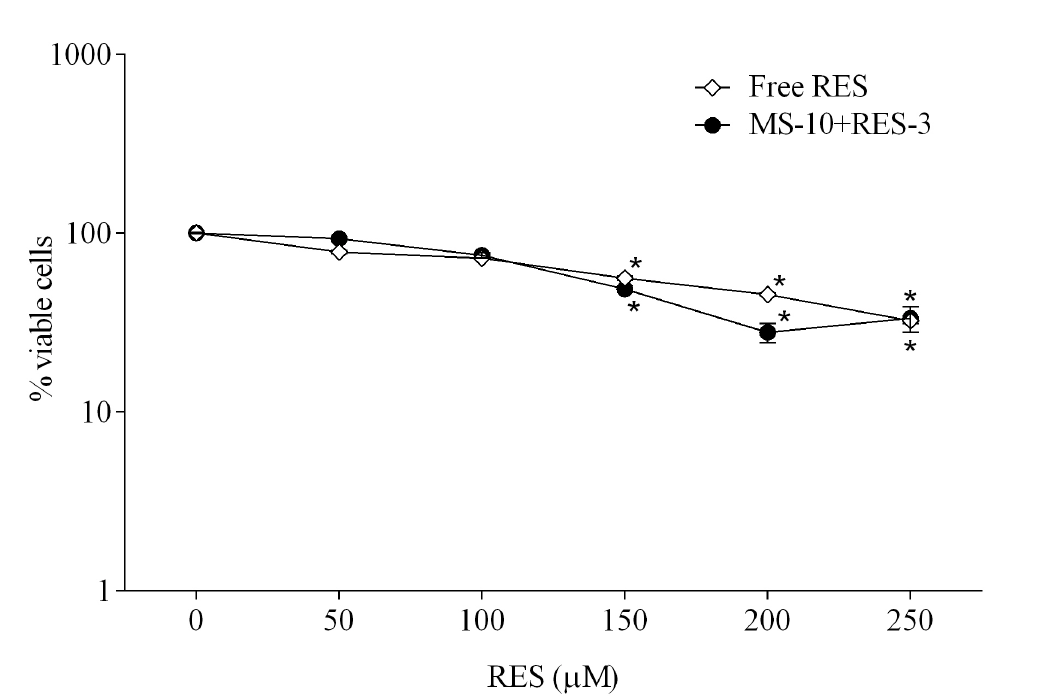
FIGURE 4 - Percentage of viable T24 cells (logarithmic scale) after treatment with free RES and formulation MS-10+RES-3 (10% F127 and 5000 µM). * p < 0.05 in relation to control without treatment with resveratrol. Each point represents the mean values ± standard deviation obtained from three